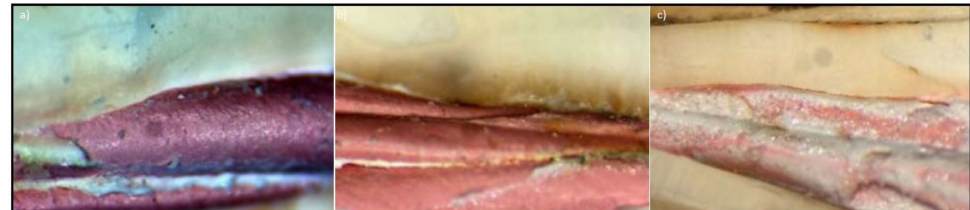
Figure 13. Connection of resilon main cone with resilon complementary cones after cold filling of the root canal with resilon (LSM): ( a , b ) with a sealant in the middle part of the root canal; ( c ) thickly coated with sealant in the periphery